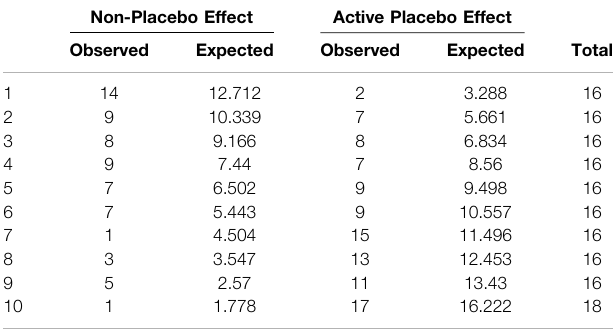
TABLE 3 | Contingency table for Hosmer – Lemeshow